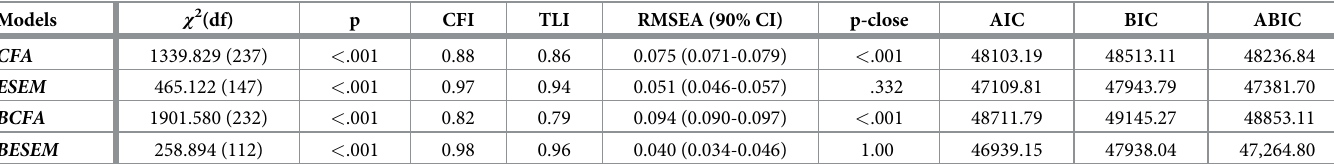
Table 2. Goodness of fit of alternative structural equation models.